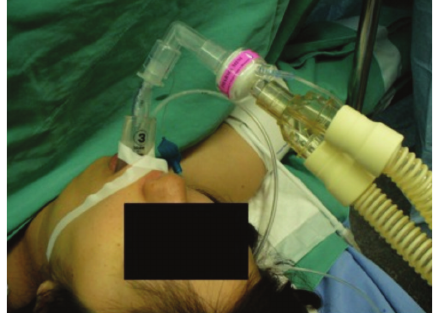
Figure1:InsertionoftheParkertrachealtubeandanasogastrictube through the